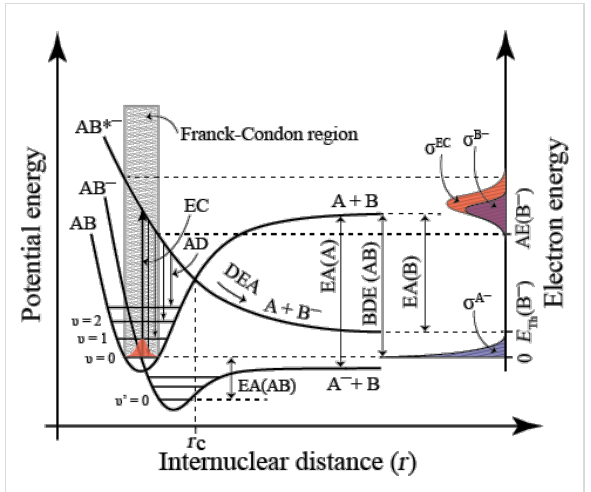
Figure 4: Simplified two-dimensional potential energy diagram for quasi-diatomic dissociation through electron attachment (DEA). The neutral ground state (AB) is depicted along with the anionic ground state (AB − ) and an electronically excited anionic state (AB* − ). Electron capture (EC) proceeds through a vertical transition (thick vertical arrow) within the Franck–Condon region (shaded area) and leads to the formation of a transient negative ion (TNI; AB − or AB* − in this case). The TNI formed can then relax through reemission of the elec- tron (autodetachment; AD) which is depicted with thin vertical arrows from AB* − to the neutral electronic ground state. In the case where this reemission process results in a transition to the ground vibrational state, the scattering process is elastic while the other arrows depict vibrationally inelastic processes. The TNI may also relax through nuclear relaxation along the respective anionic potential energy surfaces (DEA). The dissociative asymptotes are here shown to lead to A − /B and B − /A for AB − and AB* − respectively. For AB − the potential energy curve is shown crossing the vibrational ground state of the neutral; the AB − dissociative asymptote lies below this energy. Hence, the electron affinity of A (EA(A)) is larger than the bond dissociation energy of AB (BDE(AB)). Attachment of a 0 eV electron may thus lead directly to the formation of A − . For AB* − a nuclear relaxation beyond the crossing point with the neutral ground state (r c ) must lead to disso- ciation, as AD is not possible for nuclear separation beyond this point. The thermochemical threshold for this process ( E th (B − )) is given by the difference between the electron affinity of B and the BDE(AB) as depicted on the right-hand y-axis. The appearance energy (AE) for the fragment B − , conversely, is defined by the Franck–Condon overlap and is, in this case, substantially higher than E th (B − ). This is depicted on the right-hand y -axis, in terms of the reflection principle , which shows the energy dependence of the electron capture cross section ( σ EC ) as a reflection of the Franck–Condon overlap. The DEA cross section ( σ B − ), which is the product of the attachment cross section and the survival probability of the TNI, i.e., the likelihood that the nuclear relax- ation exceeds r c before autodetachment is also